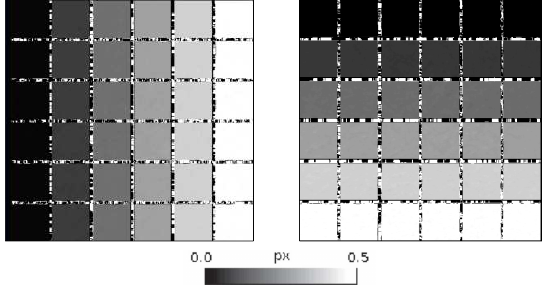
Figure 9 : Medicis 2D disparity map obtained with the same parameters as the one used in Figure 7, except the correlation window size that is 33*33.